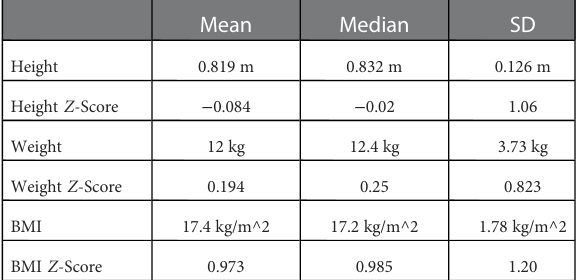
TABLE 1 Anthropometric information for total cohort ( n